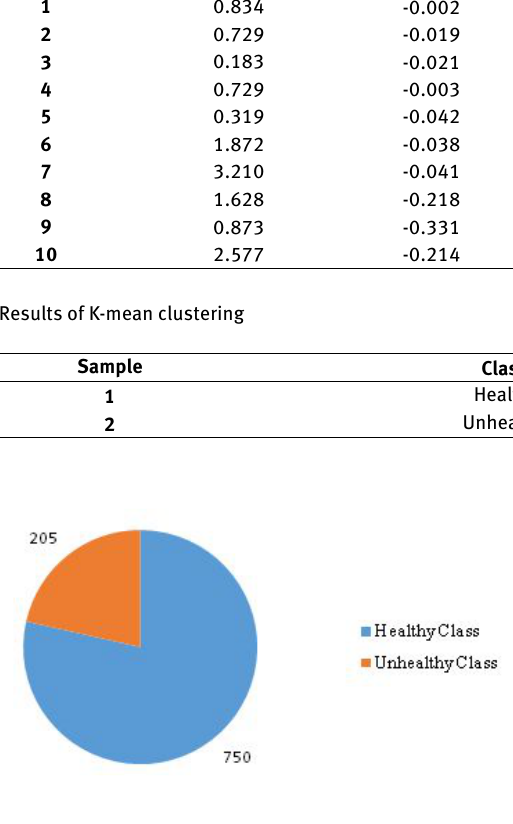
are included in it, the physical center and the cyber cen- ter. The sensors, actuators and the maintenance team